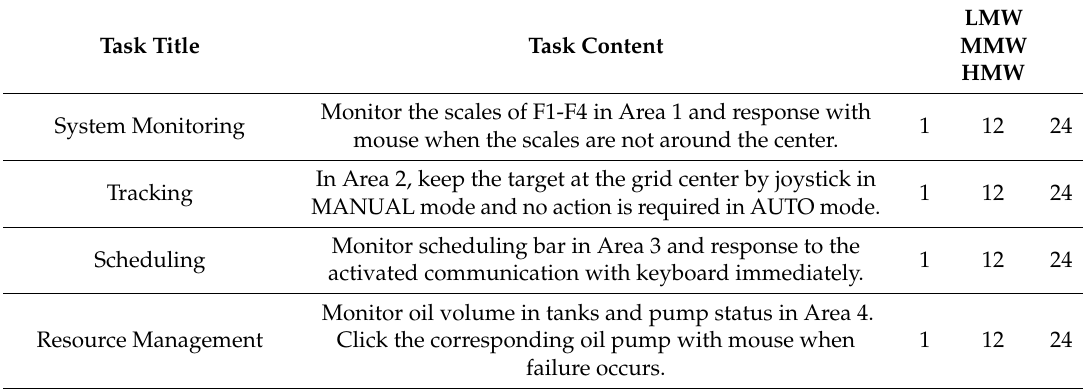
Table 1. Occurrence frequency of four tasks.